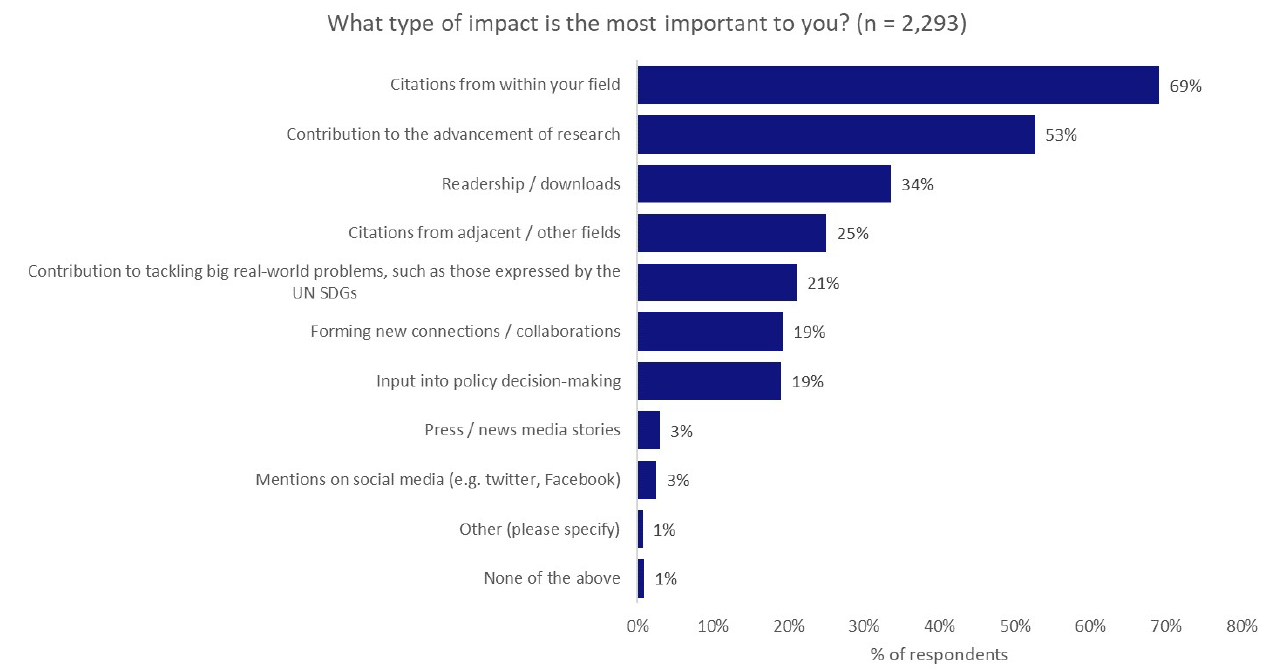
Figure 3: ‘ contribution to the advancement of research ’, ‘ con-